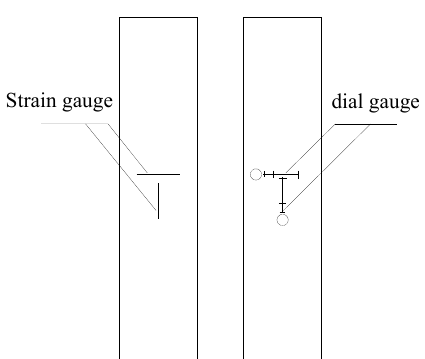
Figure 4. Loading test.